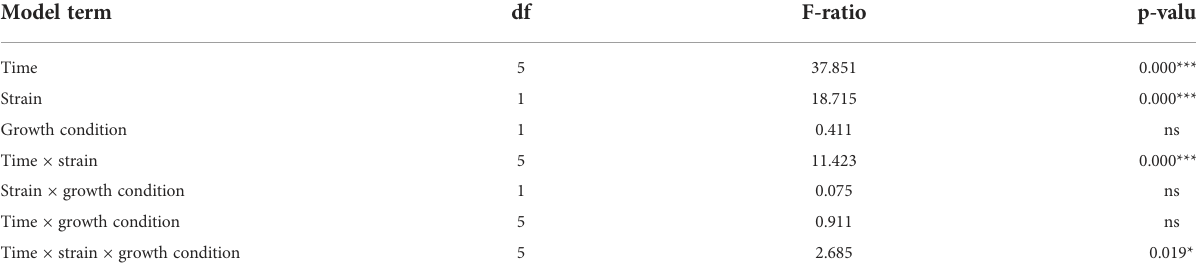
TABLE 2 Beta regression analysis for testing the cytotoxic effect of P. salmonis on CHSE-214 cell line. Model term